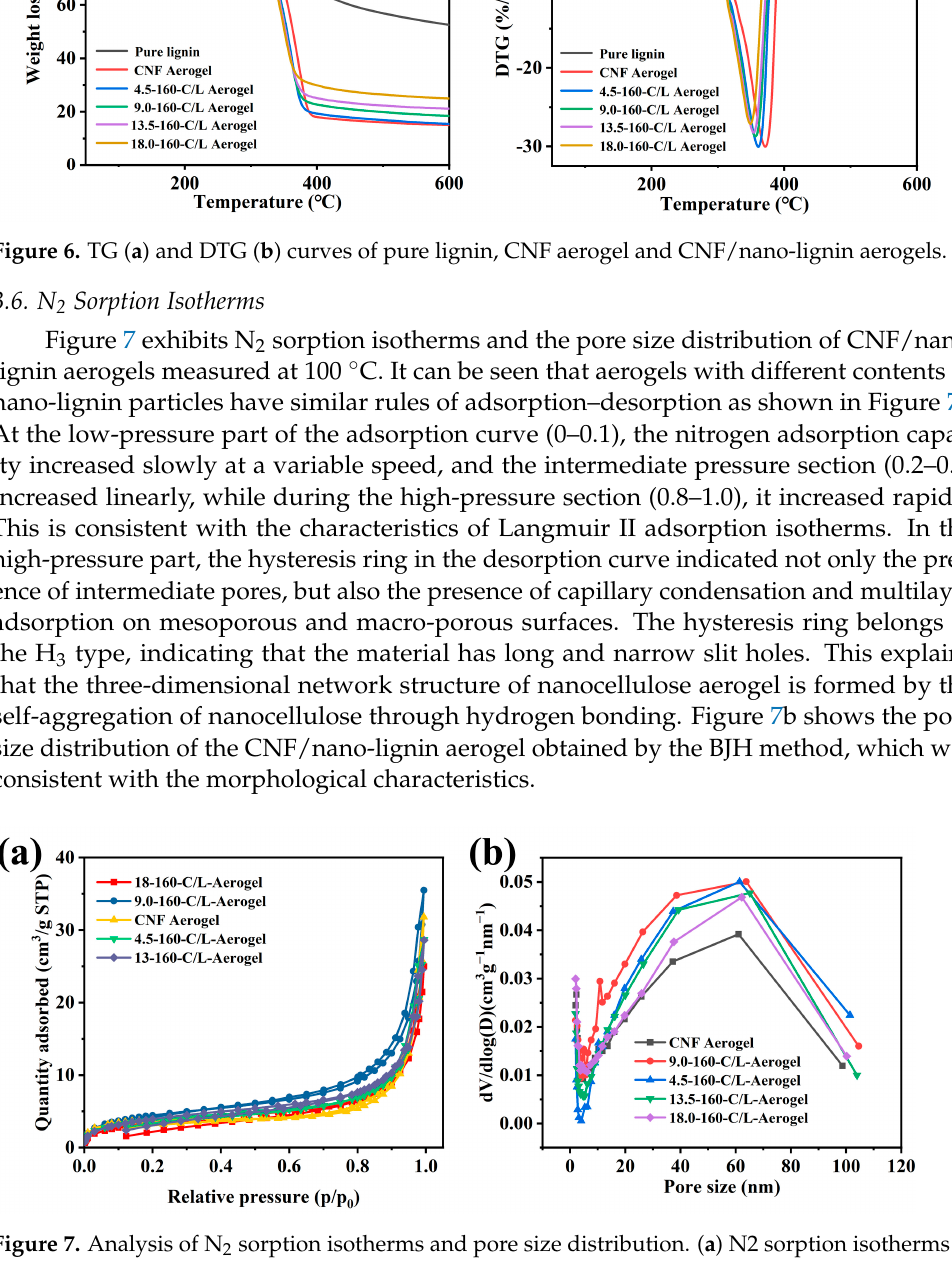
Table 1. Lignin content, density, mechanical properties, and specific surface area of CNF/nano-lig- nin aerogels and CNF aerogel.